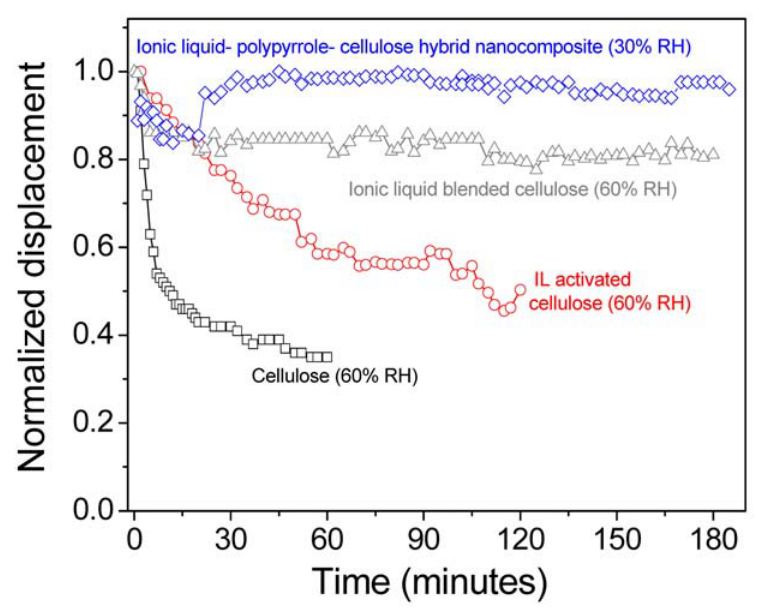
Figure 8. Compared durability of EAPap actuators.